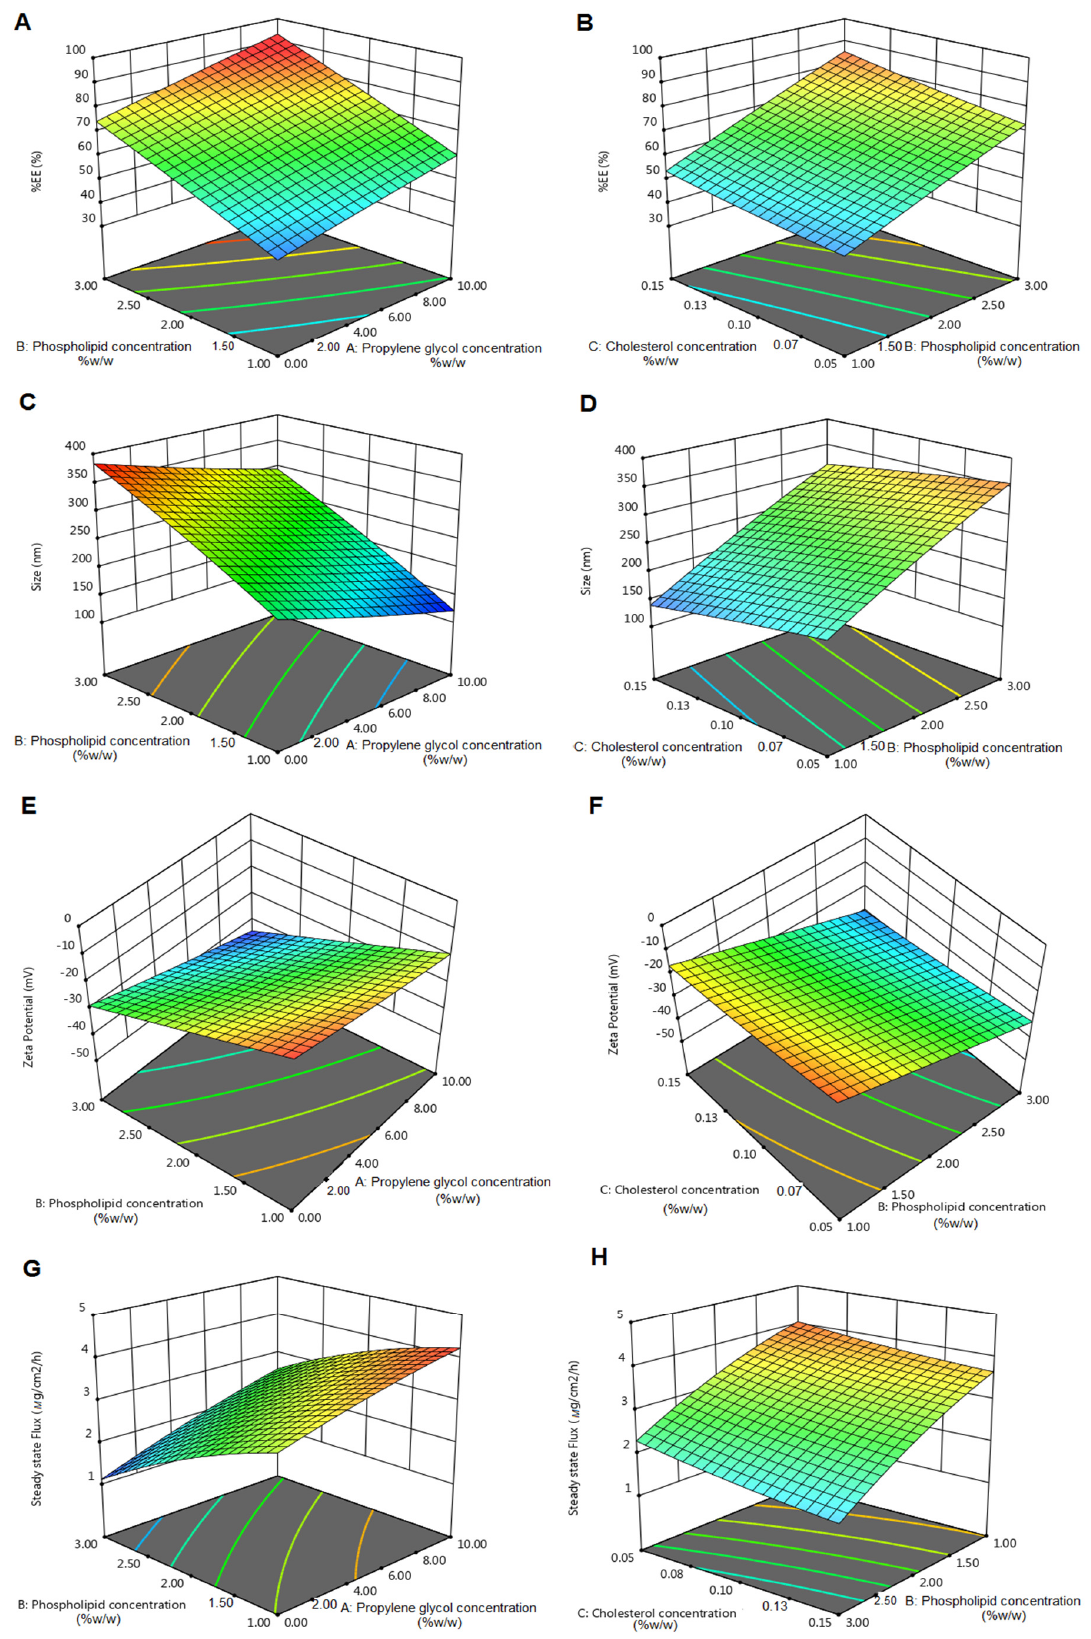
Figure 1. 3D response surface plots showing the effect of phospholipid and PG concentrations and the effect of phospholipid and cholesterol concentrations on % EE ( A , B ), particle size ( C , D ), zeta potential ( E , F ) and steady state flux ( G , H ).